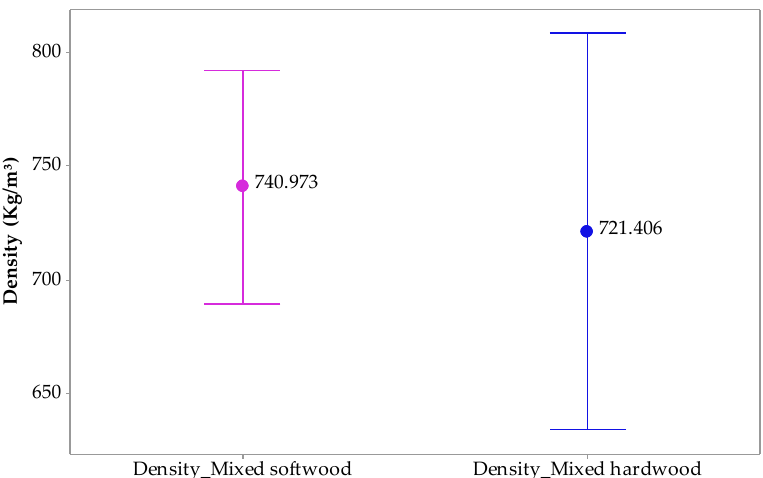
Figure 2. Interval plot of density for the analyzed types of OSBs.